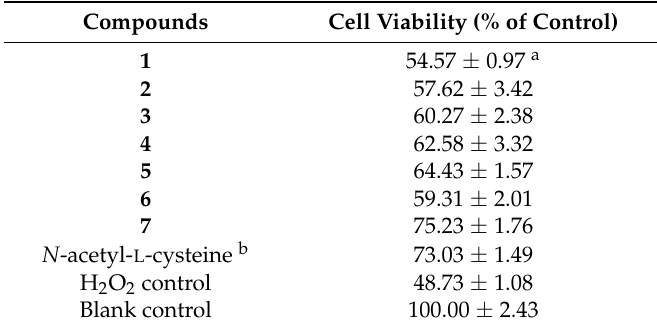
Table 2. Effect of isolated compounds on SH-SY5Y cell damage induced by H 2 O 2